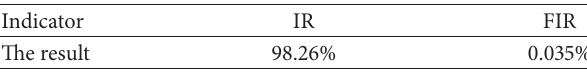
Table 9: Evaluation results of the